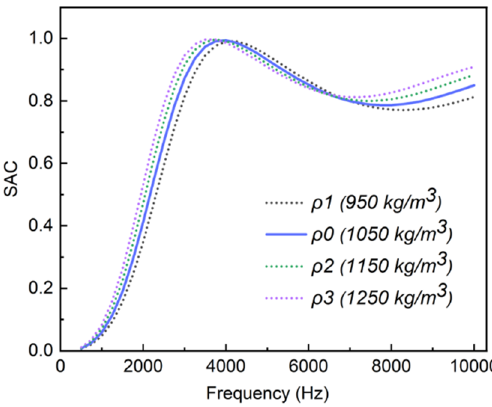
Figure 7. The SAC results of the PU ‐ based composite with different ρ .